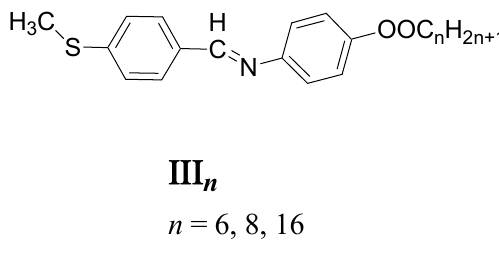
Figure 5. 4-(Methylthio)benzylidene-4 ′ -n-alkanoyloxyanilines, III n .